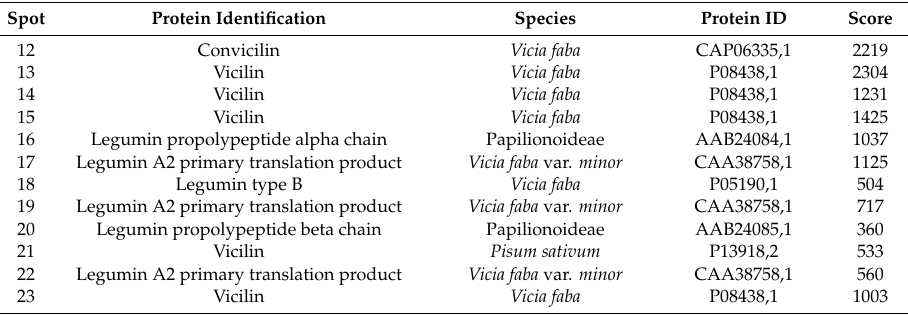
Table 4. Legumin identification fraction by LC-MS-MS /